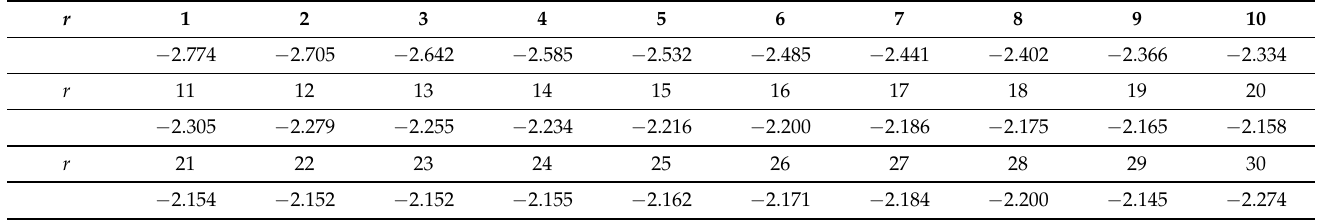
Table 3. ξ ∗ ( Y [ r :31 ] ) for